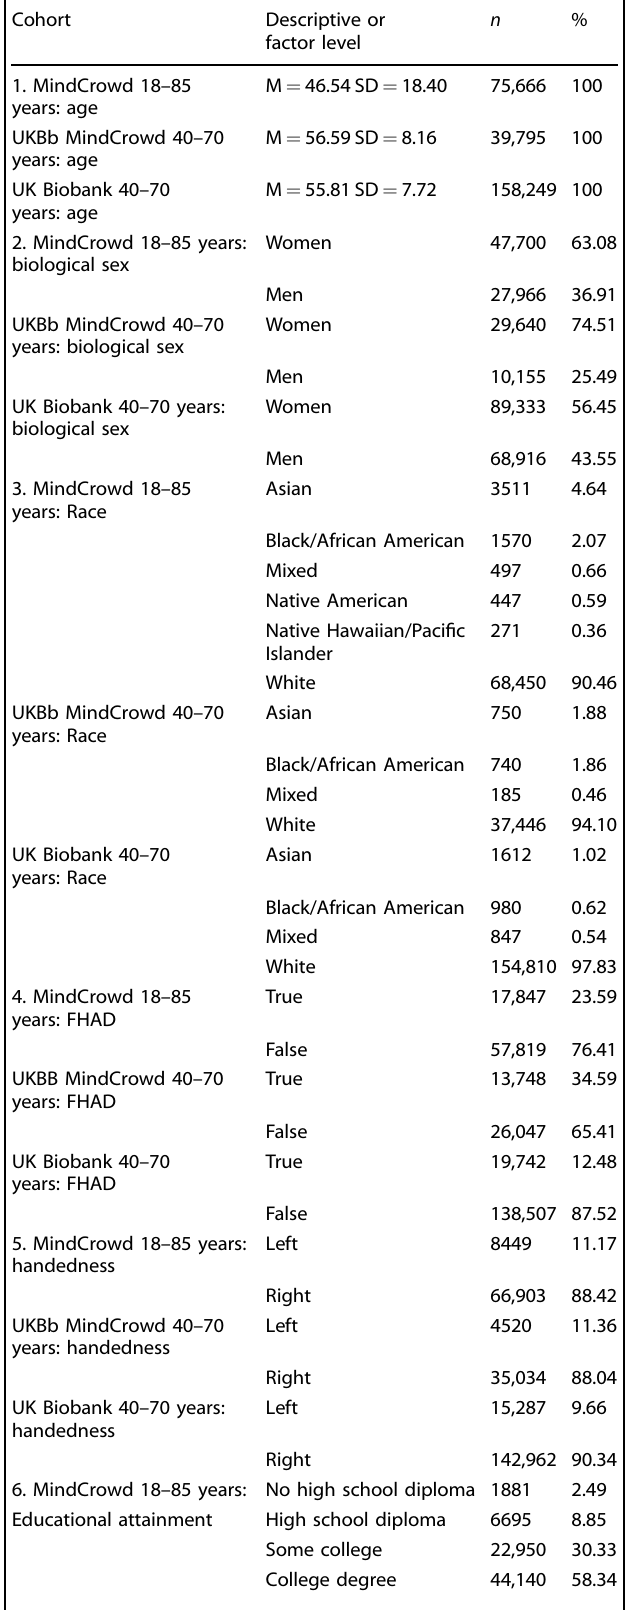
Table 1. MindCrowd, UKBb MindCrowd, and UK Biobank ’